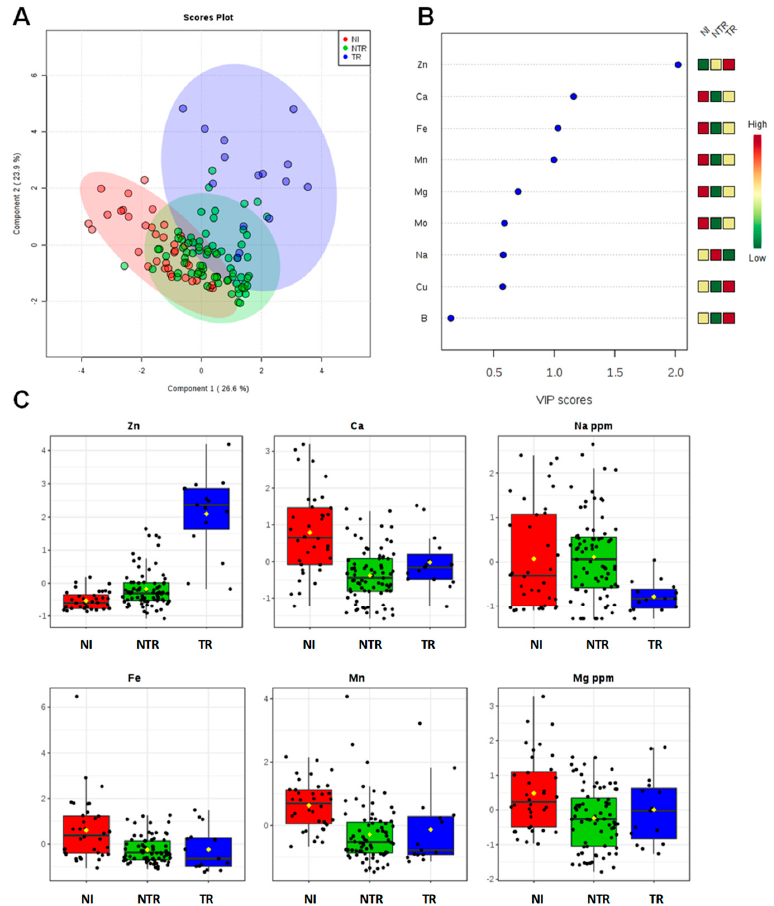
Figure 2. PLS-DA scoreplot ( A ), importance of variables ranked by VIP (Variable Importance in Projection score) ( B ) and box plot for the discriminant elements ( C ) obtained for olive leaf samples. (Figure 2B: the colored boxes on the right indicate the relative increase / decrease of the corresponding variable in each group). TR (farm treated with zinc–copper–citric acid), NTR (farm not treated and infected by Xylella fastidiosa subsp. pauca ) and NI (farm not infected by Xylella fastidiosa subsp. pauca ).